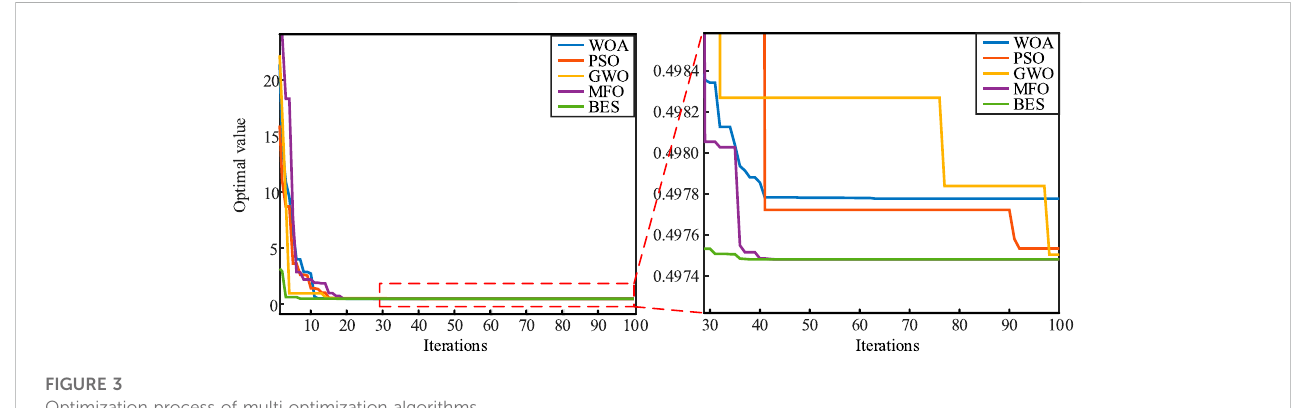
FIGURE 3 Optimization process of multi optimization